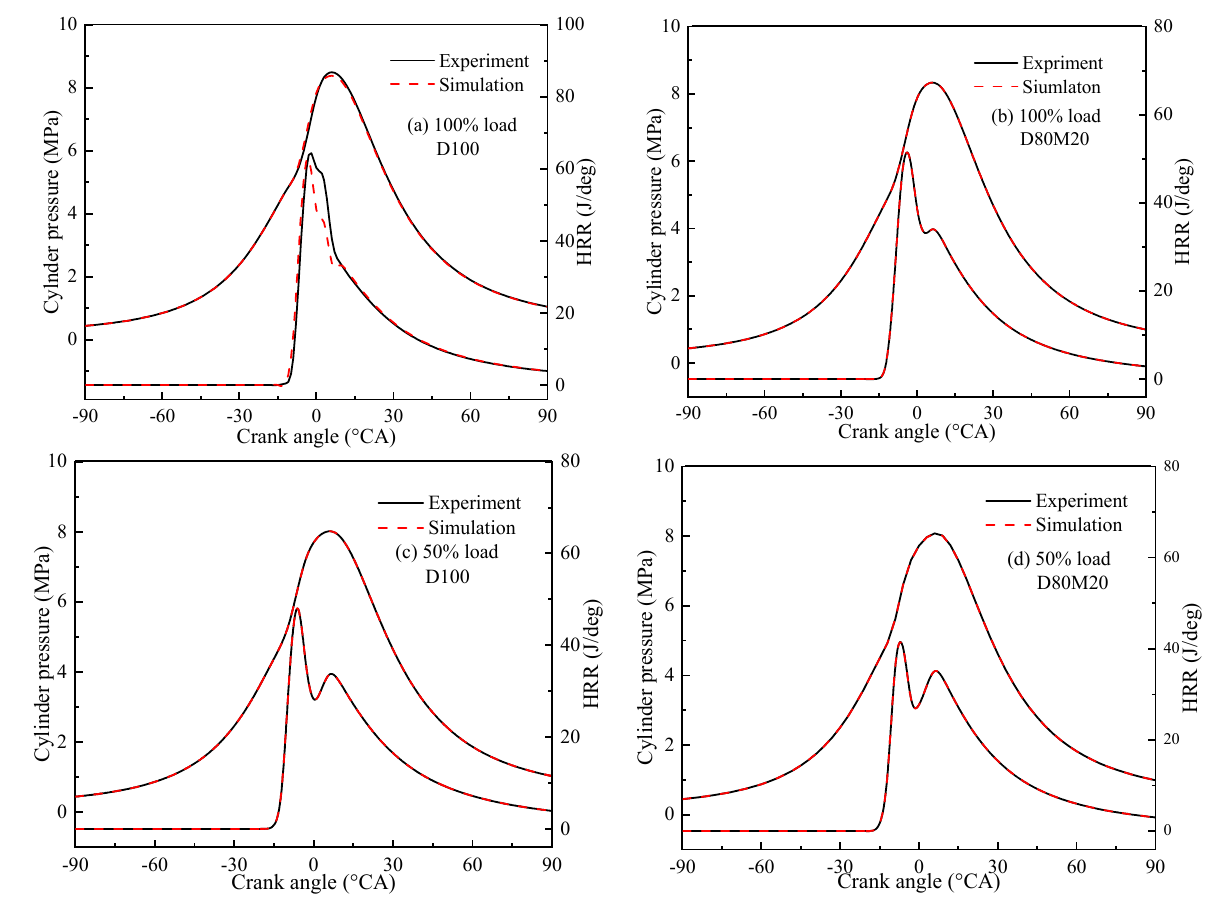
Figure 4. Comparison of cylinder pressure and HRR of different proportions of diesel–methanol blended fuel under different load conditions. ( a ) D100 at 100% load, ( b ) D80M20 at 100% load, ( c ) D100 at 50% load, ( d ) D80M20 at 50% load.